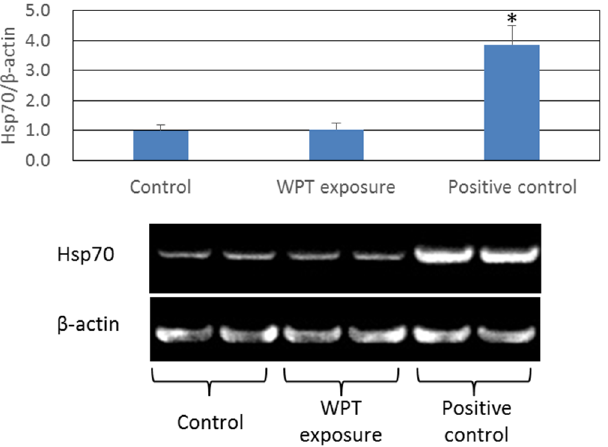
Figure 2. The expression of Hsp 70 in WI38VA13 subcloned 2RA human fibroblast cells exposed to WPT and control cells for 24 h, or heated at 43 °C as positive control. The expression of Hsp 70 was standardized to that of β -actin. Data are presented as means ± SD from three separate experiments. Photograph shows the typical results of Western blotting. * p < 0.05 compared with control.